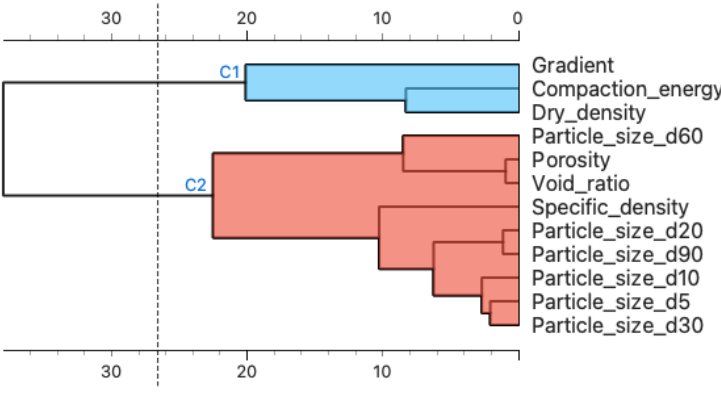
Figure 6. Hierarchical clustering.